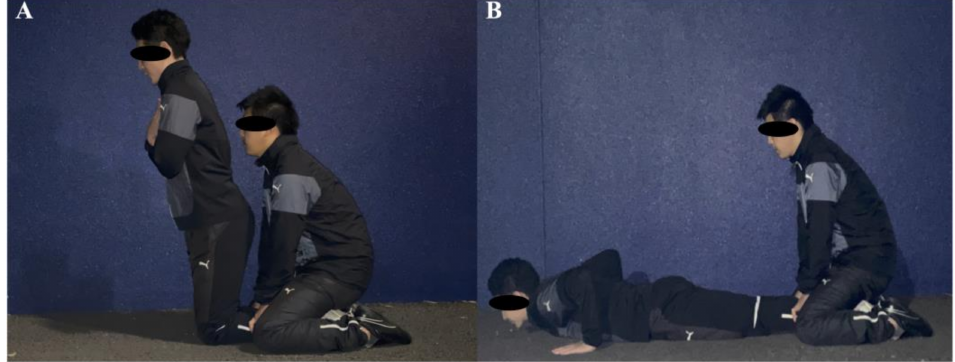
Figure 2. The Nordic hamstrings exercise. ( A ) Starting position, ( B ) End position of the hamstrings muscle strengthening